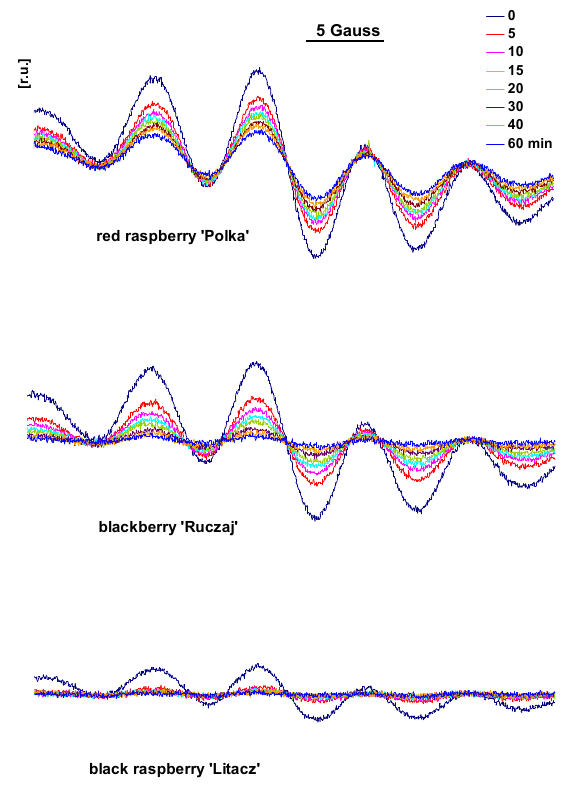
Figure 2: Raw L -band EPR spectra of DPPH scavenging by extracts of berry fruits: red raspberry ’Polka’, blackberry ’Ruczaj’, and black raspberry ‘Litacz’. Each curve represents the mean of five individual scans. The samples were prepared of fruits collected in